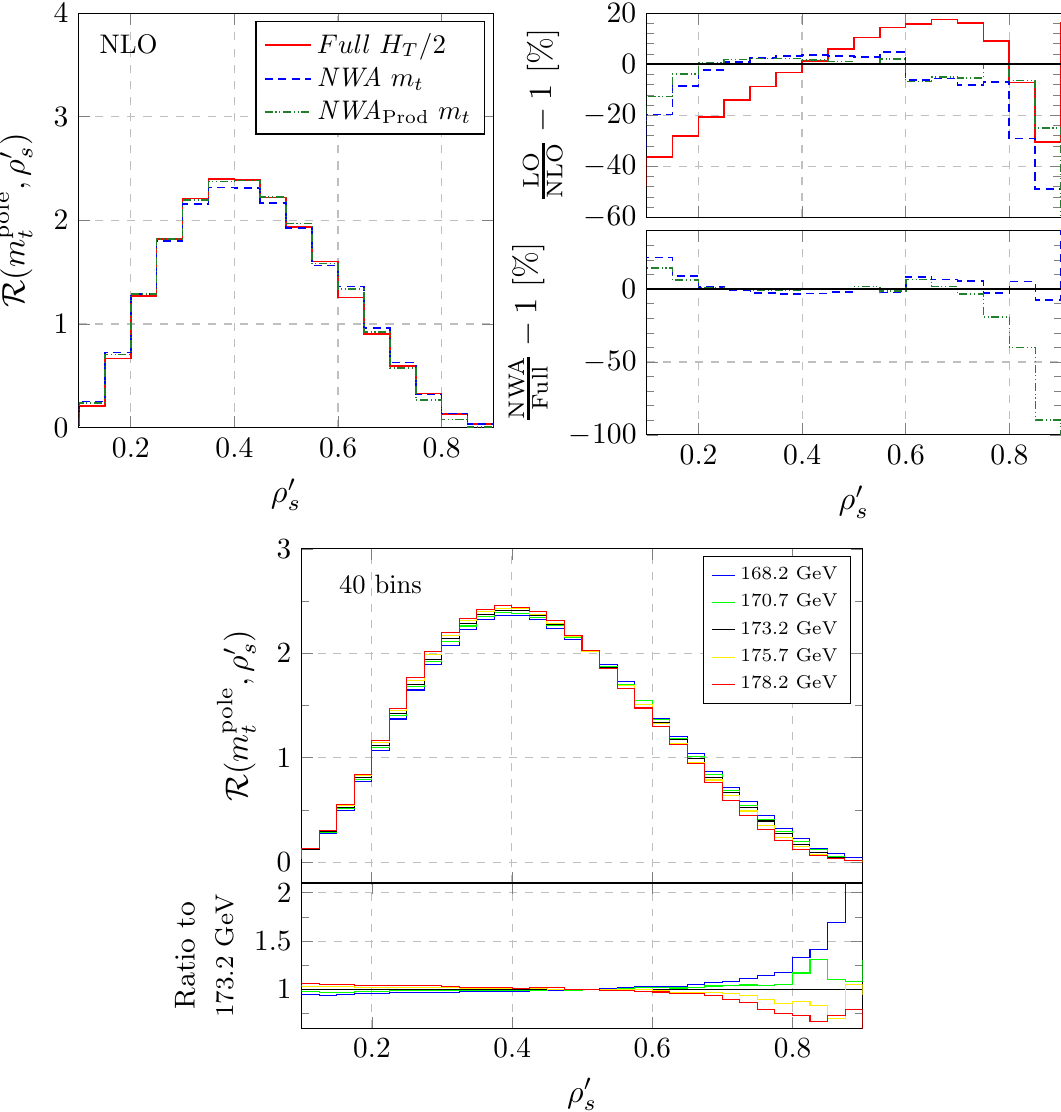
(cid:22) bj + X production + (cid:23) e (cid:22) (cid:0) (cid:22) (cid:23) (cid:22) b